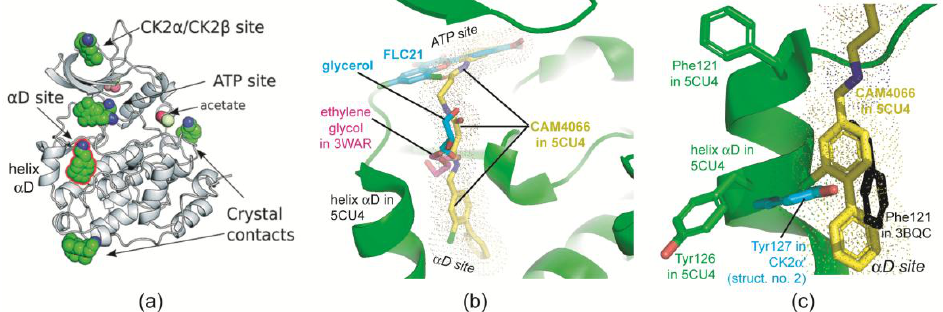
Figure 6. Molecular fragments at a novel αD site, at the ATP site and along the interconnecting path. ( a ) Brear et al. [39] found 2-(3,4-dichlorophenyl)ethanamine (green balls for carbon atoms) at several cavities of CK2α and identified in this way the αD site. The picture was taken and slightly modified from [39], published by The Royal Society of Chemistry; ( b ) Section of a complex structure of CK2α with the bivalent inhibitor CAM4066 (PDB 5CU4 [39], CAM4066 with yellow carbon atoms). After structural superimposition elements of PDB file 3WAR [36] (ethylene glycol, magenta coloured C -atoms) and of chain B of the monoclinic CK2α′ Asp39Gly/Cys336Ser /FLC21 complex (light blue C -atoms) are drawn; ( c ) The αD site is occupied by Phe121 in CK2α structures with closed hinge/helix αD conformation (here represented by 3BQC; black) or partially by Tyr126 (Tyr127 in CK2α′; here drawn in light blue from structure 2 of Table 1) in structures with open hinge/helix αD conformation. αD site ligands like CAM4066 replace both of them.